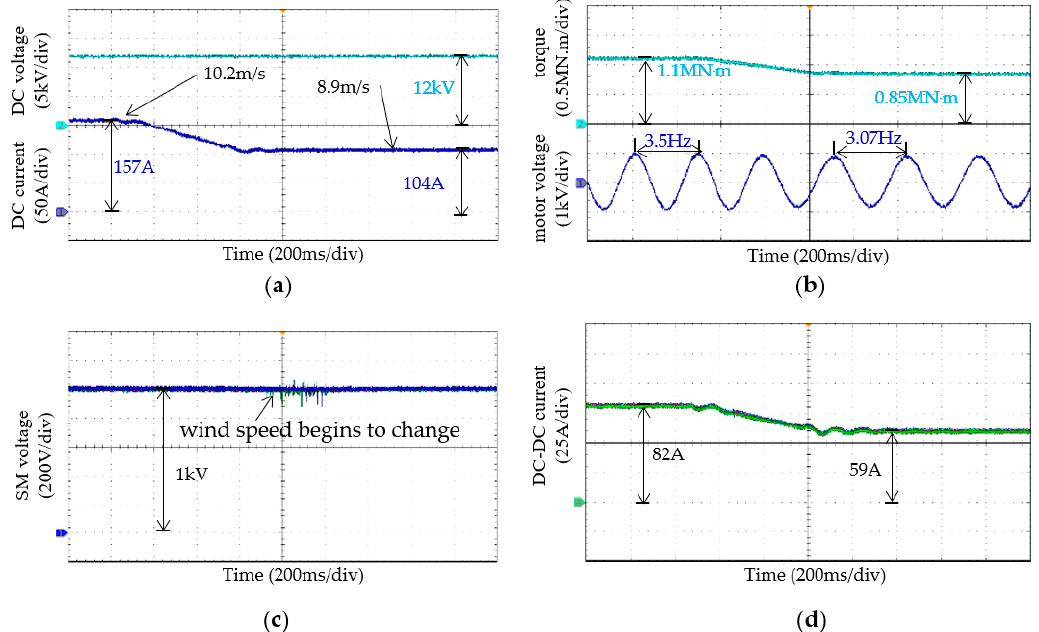
Figure 9. Experiment results when wind speed changes: ( a ) DC transmission voltage and current; ( b ) Terminal voltage of PMSG and electromagnetic torque; ( c ) SM capacitor voltages; ( d ) Currents of DC–DC converters.